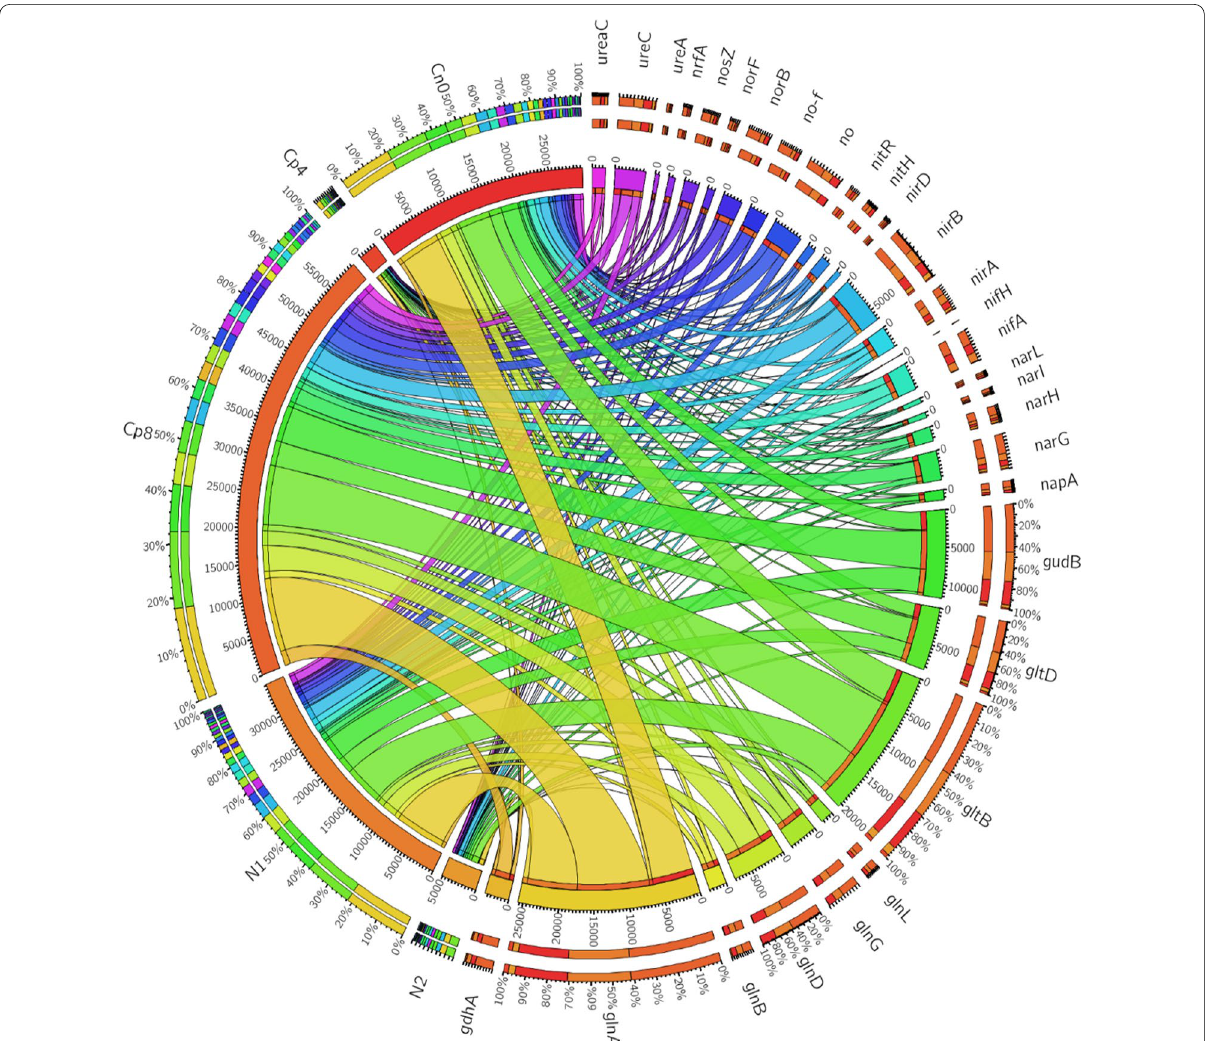
Fig. 3 Nitrogen cycling genes found in maize rhizosphere soil under fertilizer treatments plotted with an online software—Circos. The meaning of the gene abbreviations are ( glnA ) glutamine synthetase, ( gltB ) glutamate synthase (NADPH/NADH) large chain, ( gudB ) glutamate dehydrogenase, ( glnD ) uridylyltransferase, ( gltD ) glutamate synthase (NADPH/NADH) small chain, ( nirB ) nitrite reductase (NAD(P)H) large subunit, ( narG ) nitrate reductase 1, alpha subunit, ( gdhA ) glutamate dehydrogenase (NADP ), ( glnG ) two-component system, nitrogen regulation response regulator + GlnG, (no) nitrate reductase catalytic subunit [EC:1.7.99.4], ( ureC ) urease subunit alpha, ( nifA ) Nif-specific regulatory protein, (no-F) nitrite reductase (NO-forming), ( norB ) nitric oxide reductase subunit B, ( nosZ ) nitrous-oxide reductase, ( glnB ) nitrogen regulatory protein P-II 1, ( ureaC ) urea carboxylase, ( narH ) nitrate reductase 1, beta subunit, ( nirA ) ferredoxin-nitrite reductase, ( glnL ) two-component system, nitrogen regulation sensor histidine kinase, ( napA ) periplasmic nitrate reductase, ( nrfA ) cytochrome c-552, ( nitH ) nitrile hydratase, ( nitR ) nitrate reductase (NADH), ( norF ) nitric-oxide reductase, ( narI ) nitrate reductase 1, gamma subunit, (urea) urease subunit gamma, ( nirD ) nitrite reductase (NAD(P)H) small subunit, ( narL ) two-component system, nitrate/nitrite response regulator, ( nifH ) nitrogenase iron protein NifH. Note: no, ureaC, nitH, no-f and nitR are our own abbreviation to contain it within the circos plot. These genes have no specific symbol or abbreviations representing